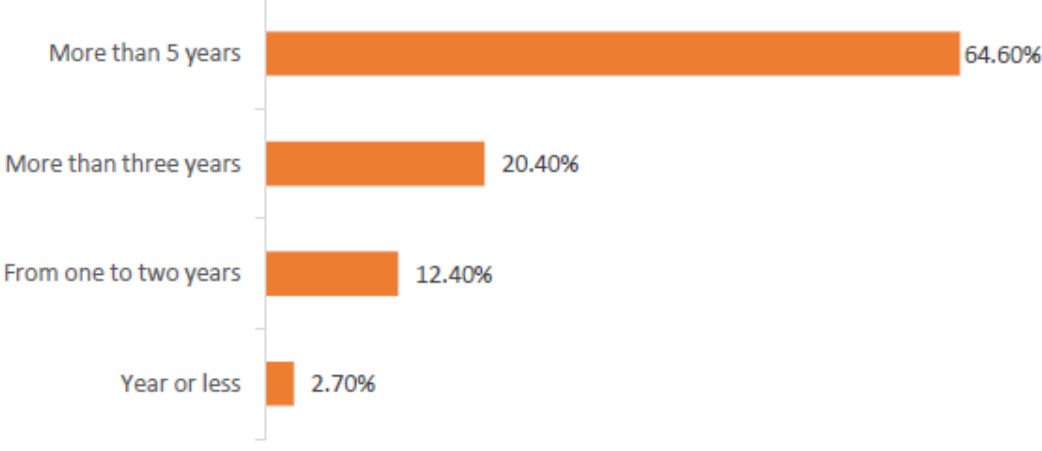
Figure 1. The prevalence of the most commonly used Androgenic – Anabolic Steroids (AAS) brands (generic).